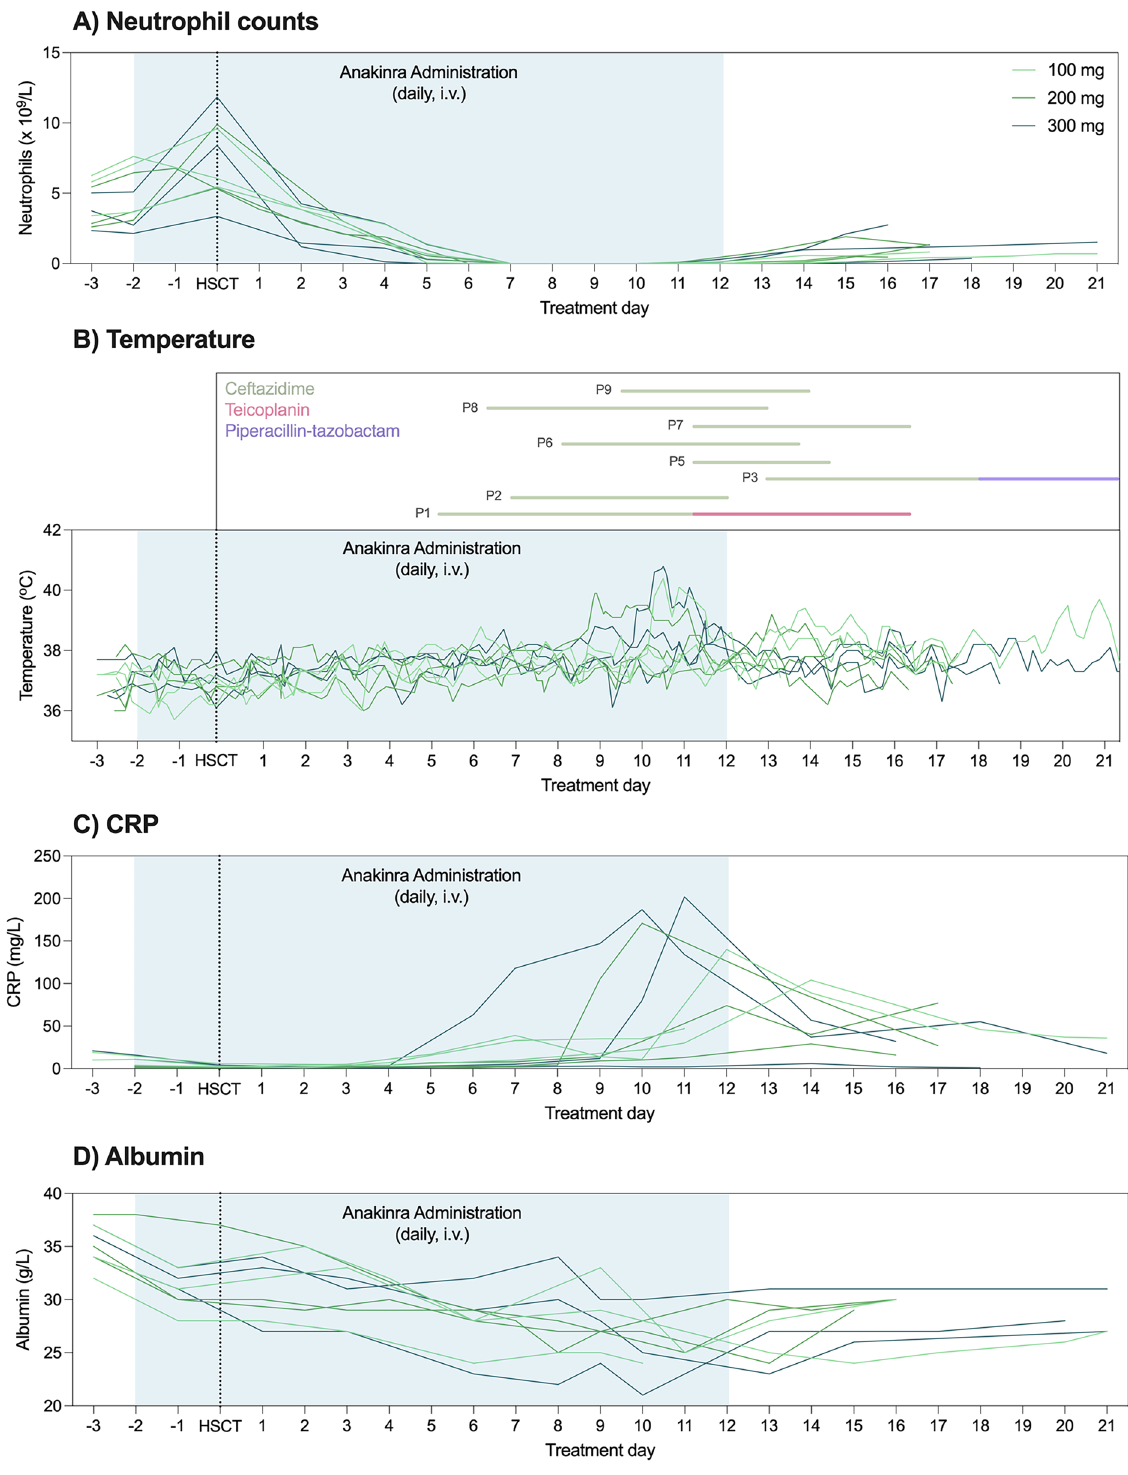
Figure 6. Clinical assessments in Phase IIA AFFECT-1 cohort treated with 100, 200 or 300 mg anakinra. ( A ) Neutrophils, ( B ) temperature with data on antbiotic use, ( C ) CRP and ( D ) albumin were assessed longitudinally in all participants. No differences were detected in any parameter. Data shown as individual participant